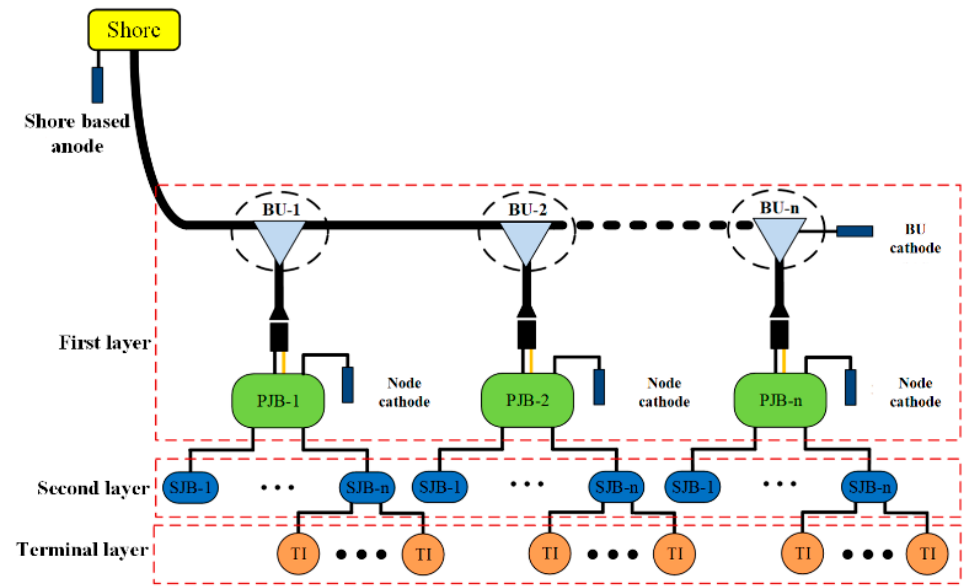
Figure 1. Overall system architecture of observation network.